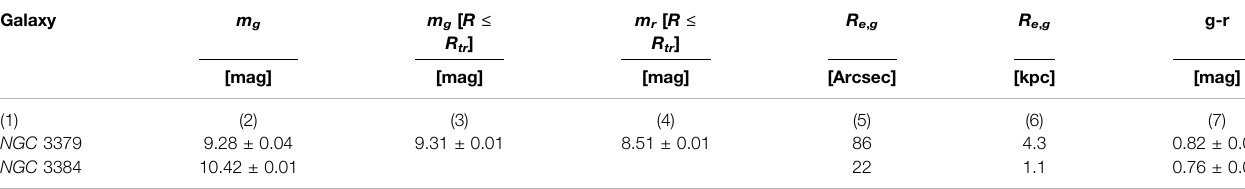
TABLE 2| StructuralparameterobtainedforthegalaxiesintheLEOIpairfrom the fi toftheisophotes. Note. Column1reportthenameofthetwopairmembers.InCol.Two isreportedthetotalmagnitude inthe g band.InCols.Threeand fourarelisted themagnitudeatthetransitionradiusin g and r bands, whileinCols.Fiveandsixaregiven theeffectiveradiusinthe g band,inarcsecandkpcrespectively.Theaverage g − r colorislistedinCol.7.MagnitudesandcolorswerecorrectedforGalacticextinctionusing the extinction coef fi cients provided by Schla fl y and Finkbeiner (Schla fl y and Finkbeiner, 2011).